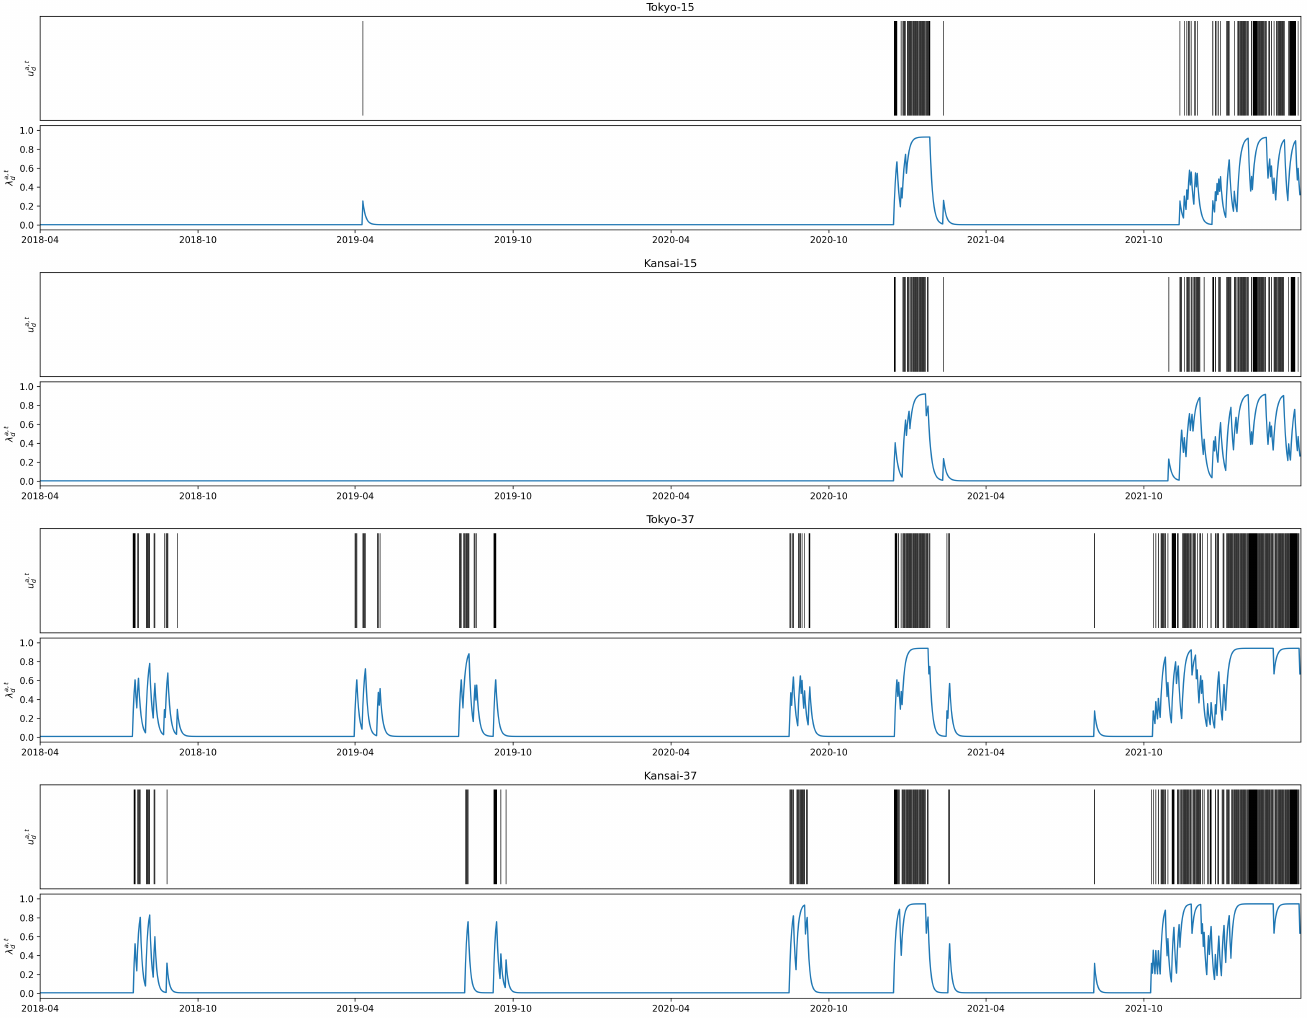
Figure 8. Evolution of the Hawkes model intensity λ a , t